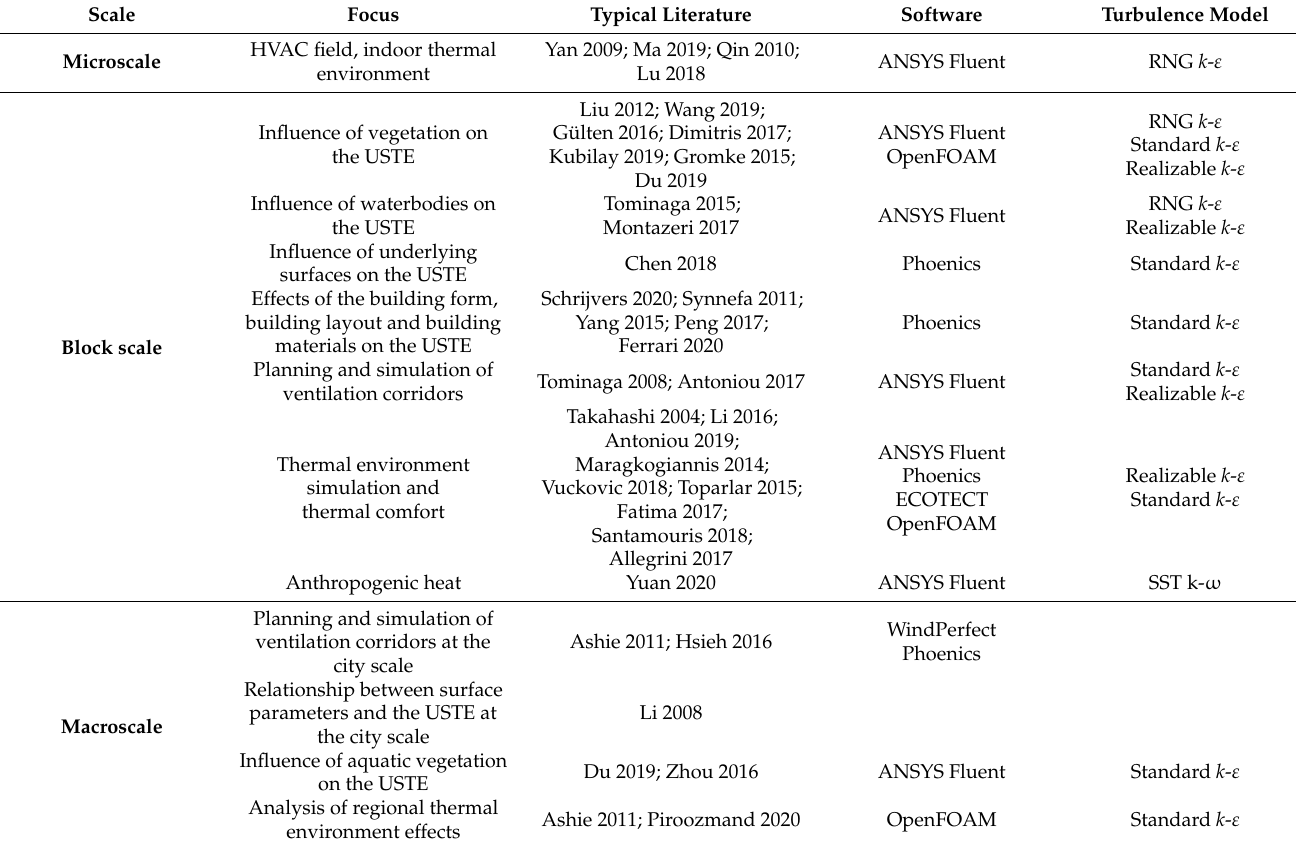
Table 4. Summary of typical studies at three different